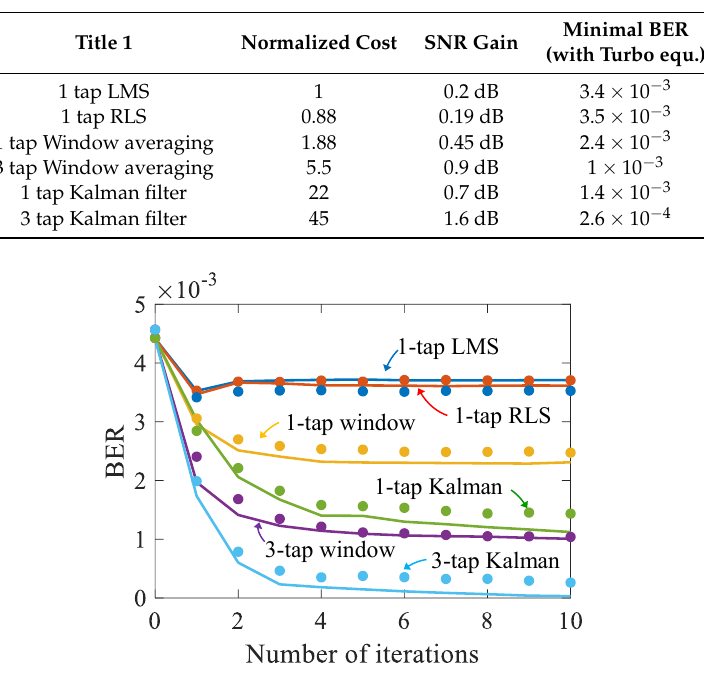
Figure 6. BER as a function of the number of Turbo-equalization iterations, using different equalizer types. The curves represent results obtained using the Virtual Lab tool [8], whereas the dots correspond to split-step simulations. Note that the case of zero iterations (leftmost point in the graph) corresponds to the case of no adaptive